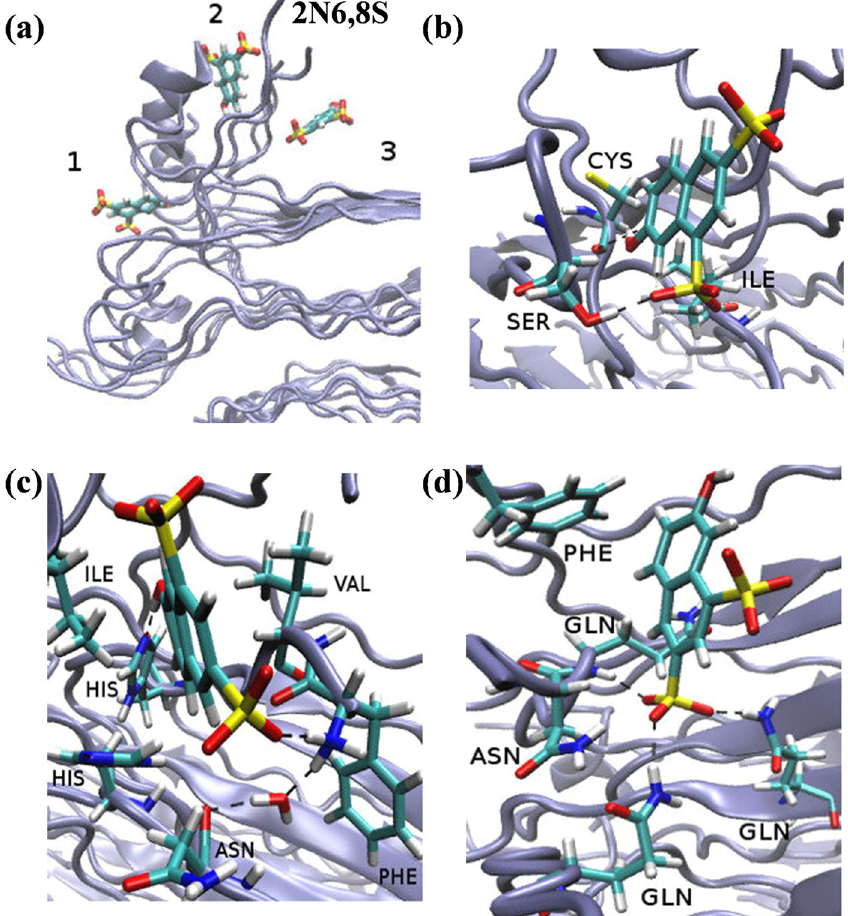
Figure 6. ( a ) A bird’s-eye view of 2N6,8S at the different binding sites on the insulin fibril surface. The close-up view of 2N6,8S in binding sites ( b ) 1, ( c ) 2, and ( d )